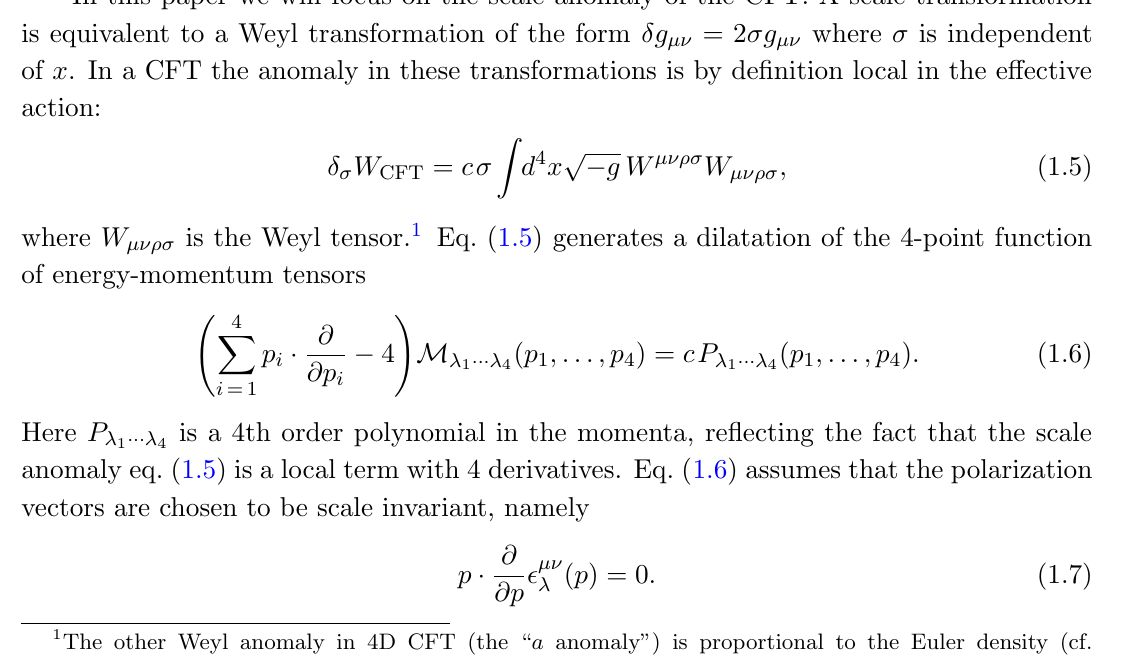
Figure 1 . Contributions to the physical graviton-graviton scattering amplitude at order 1 =M 4 Curvy double lines denote gravitons, and the blob denotes a correlation function of energy- momentum tensors in the CFT. The pseudo-amplitude corresponds to the contribution (a). The contributions (b) and (c) are important for unitarity of the physical graviton amplitude, but are not included in the